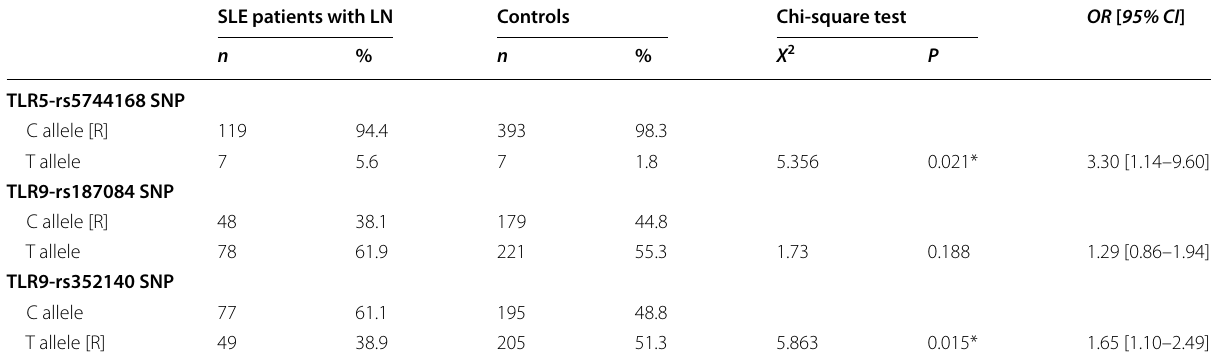
The chi-square test is used. P is set significant if